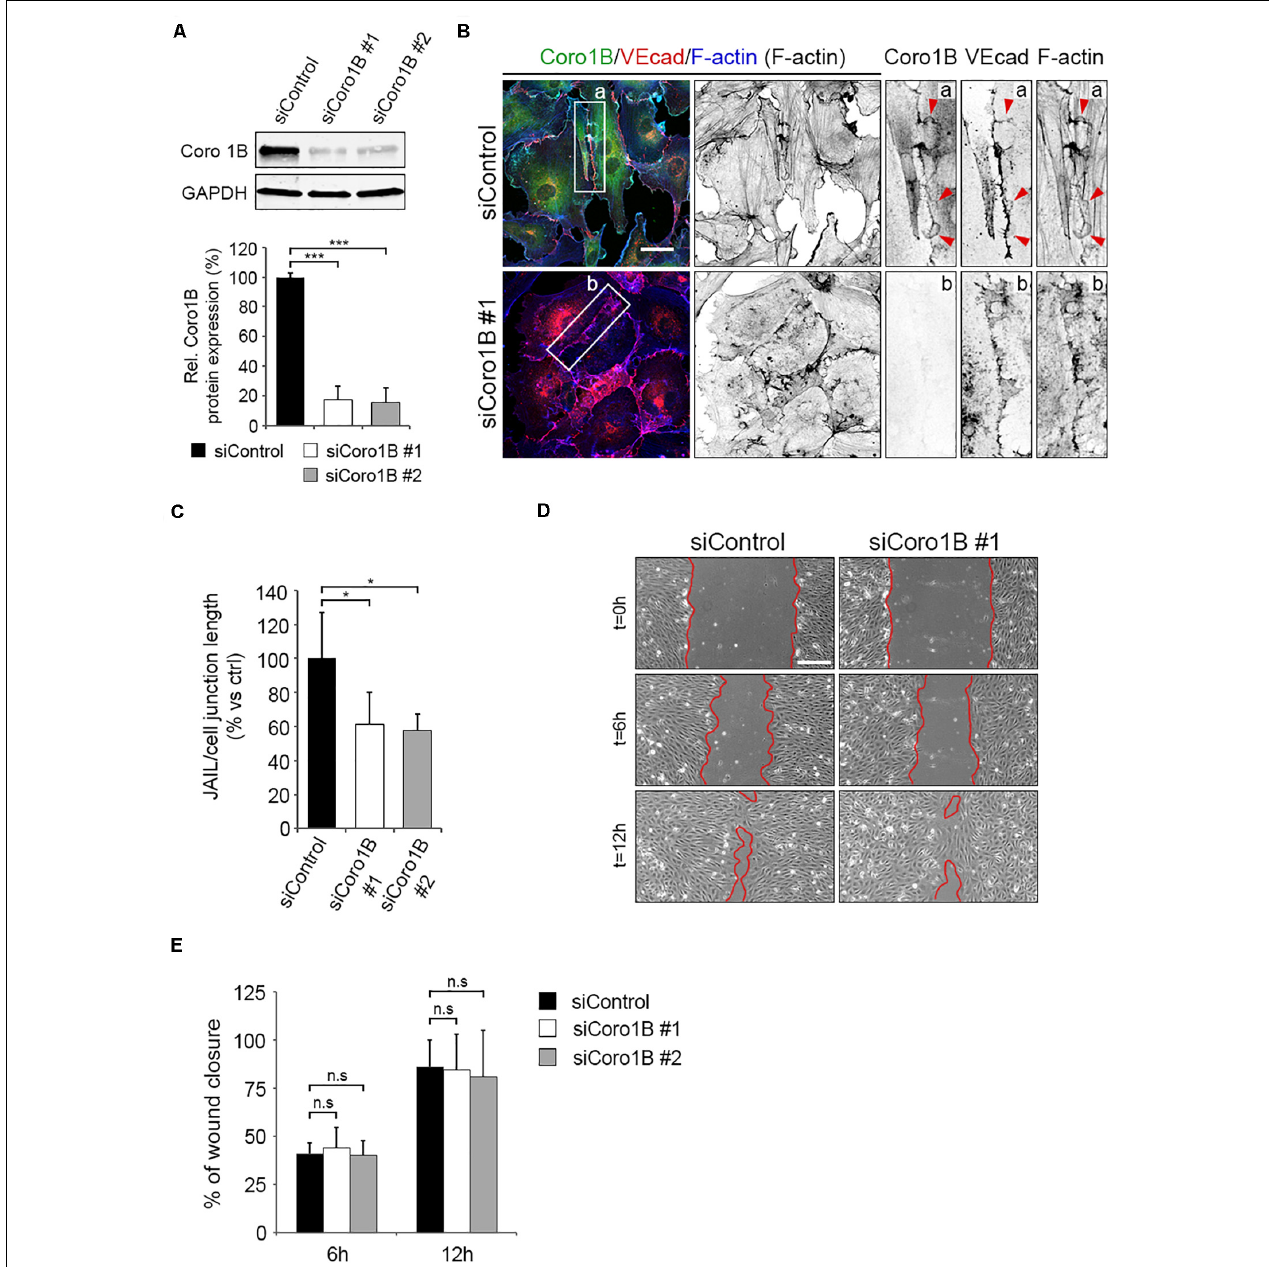
FIGURE 5 | Depletion of Coro1B in ECs alters the organization of the actin cytoskeleton and the formation of JAIL. (A) Representative western blot analysis of Coro1B and GAPDH (loading control) in total lysates of control and Coro1B-depleted HUVECs. Graph shows three independent experiments. Values represent mean ± SD. *** P < 0.001. Data are from three independent experiments. (B) Control and Coro1B-depleted HUVEC immunostained for Coro1B (green), VEcad (red) and F-actin (blue). Zoom-in indicate presence (a) or absence (b) of Coro1B at cell–cell junctions. Arrowheads point to JAIL. Scale bar = 25 µ m. (C) Quantitative analysis of JAIL number per cell–cell junction length in control and Coro1B-depleted HUVECs. Values are normalized to control. Data represent mean ± SD. * P < 0.05, n = 4. (D) Representative phase-contrast images of control and Coro1B-depleted HUVECs in a scratch-wound assay ( t = 0, t = 6, and t = 12 h after scratch). Red lines highlight the unclosed wound area. Scale bar = 200 µ m. (E) Graph showing the mean ± SD percentage of wound closure of control and Coro1B-depleted HUVECs at two time points during scratch-wound assay. Data are from three independent experiments. ns; not